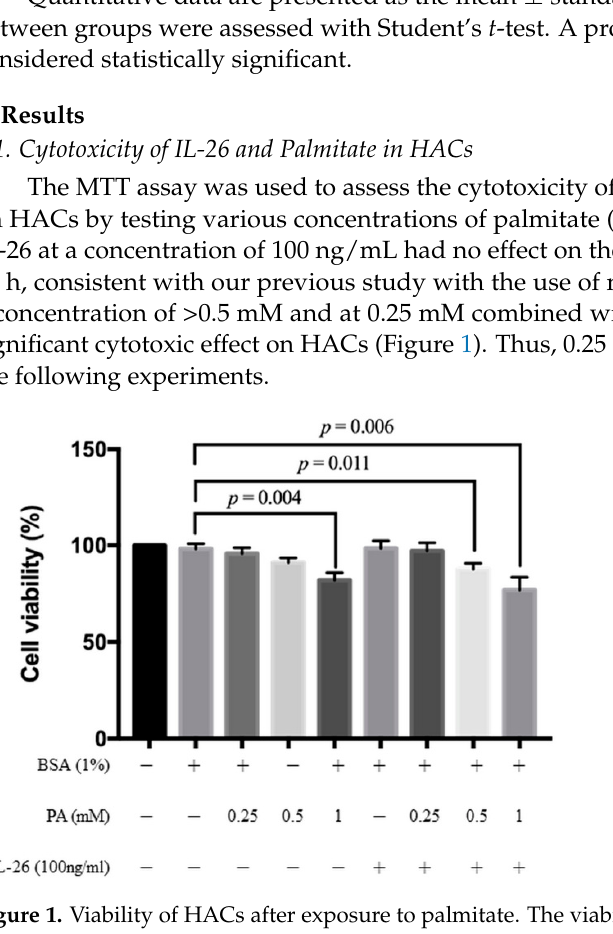
Figure 1. Viability of HACs after exposure to palmitate. The viability of primary HACs treated with palmitate (0.25, 0.5, 1 mM) and with/without IL-26 (100 ng/mL) for 24 h, as determined with the MTT assay. Data are presented as the mean ± SD. Significant differences were detected between the control and palmitate alone or palmitate + IL-26 groups ( n = 3).